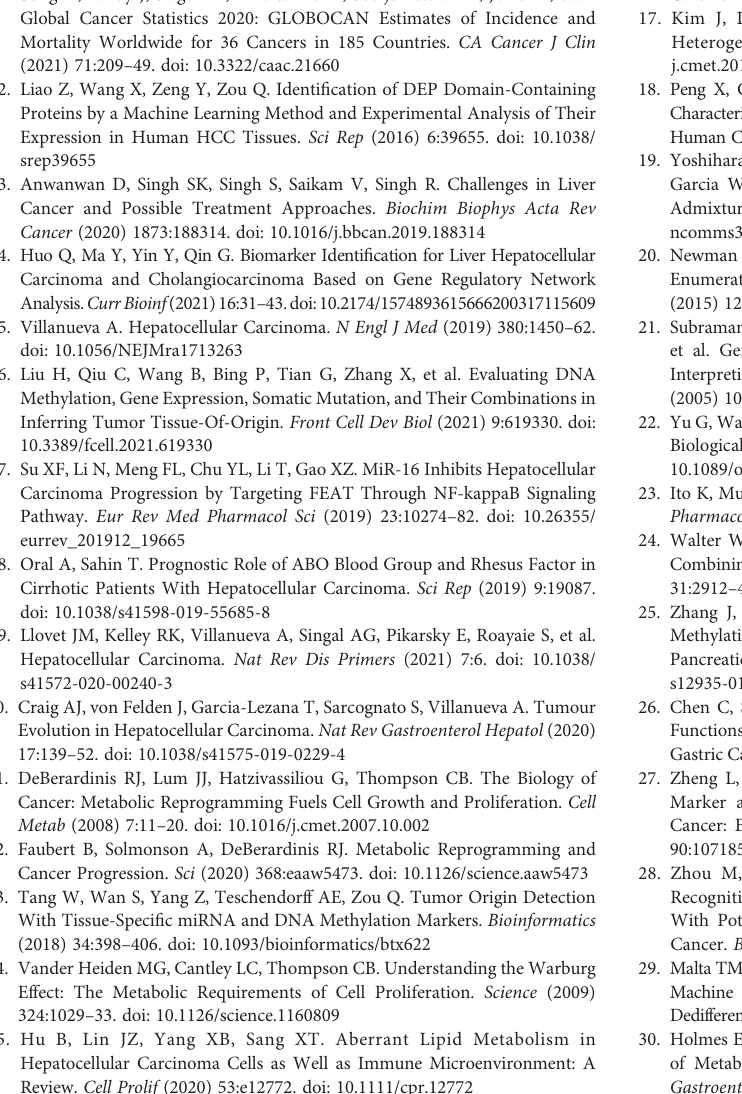
Supplementary Figure 1 | Analysis of Copy number variation. Copy number variation in (A) Metabolism_H and (B) Metabolism_L; (C) Focal copy number alterations in several genes.